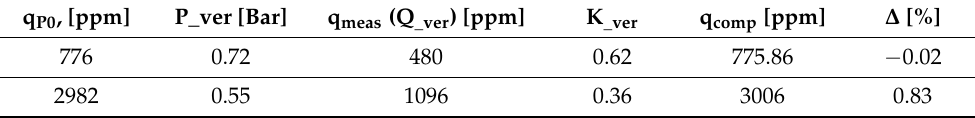
Table 6. Compensated concentrations compared to true values for different concentrations ≠ pres- sure calibration standard.